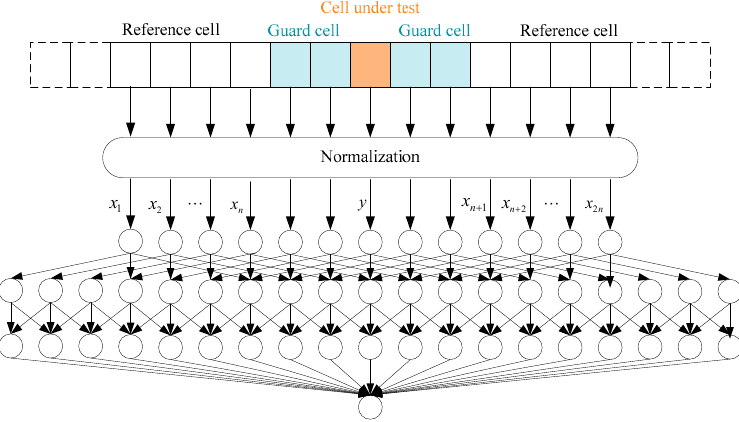
Figure 9. Artificial neural network detector structure.